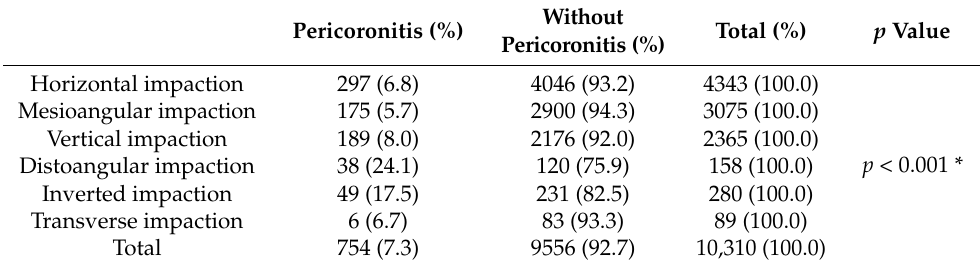
Table 10. Association between impaction angulation and pericoronitis.